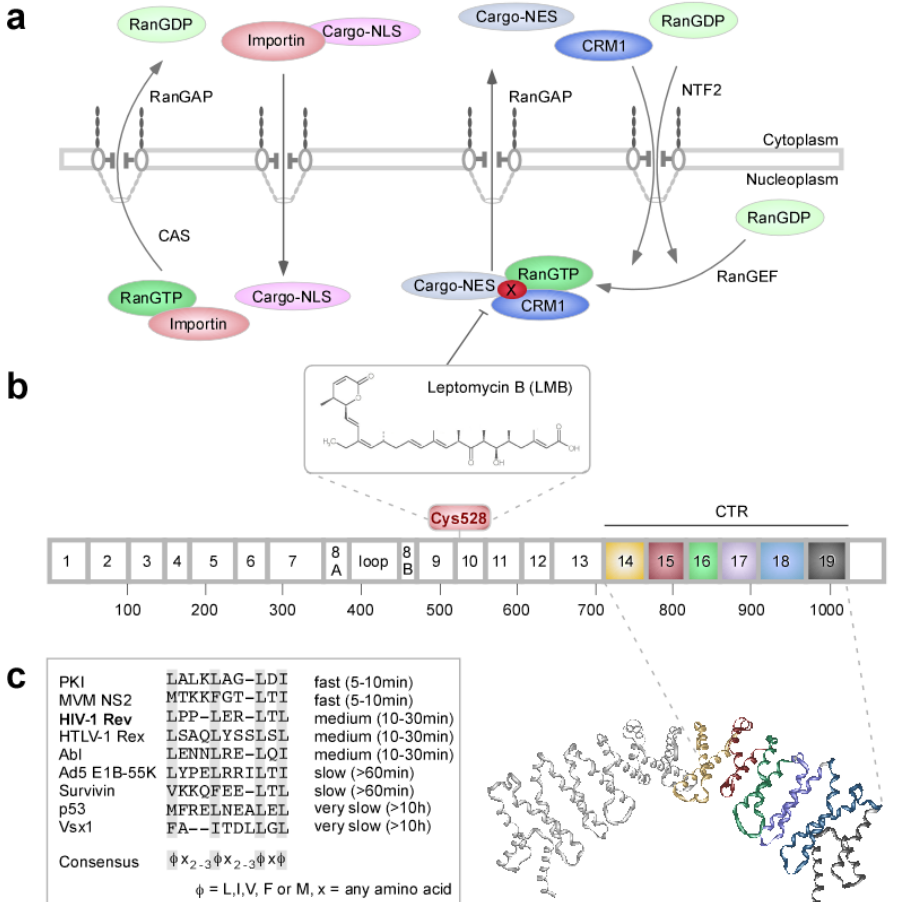
Figure 1. (a) Schematic illustration of the regulation of nucleo-cytoplasmic transport. As an example for nuclear export, the CRM1-dependent pathway is depicted. (b) Heat-repeat map of CRM1, which is predicted to contain 19 repeats separated by a loop within repeat 8. (c) Kinetic classification of NES sequences established by microinjection experiments of recombinant GST-NES-GFP substrates into the nucleus. Amino acids essential for function are highlighted in grey, putative consensus sequence for leucine-rich NES is shown